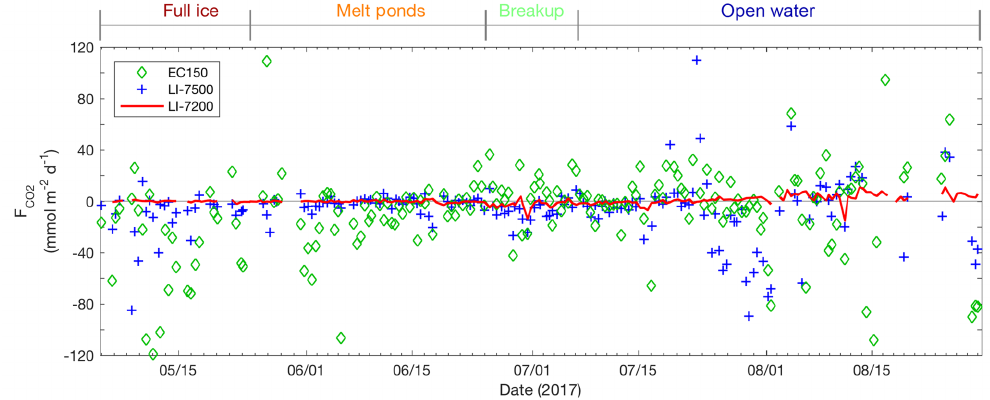
Figure 9. The 12h average CO 2 fluxes calculated using EC150 (green diamonds), LI-7500 (blue pluses), and dried LI-7200 (red line). Demarcations (determined from satellite and in situ images) of ice regimes (full ice, melt ponds, breakup, and open water) are shown on